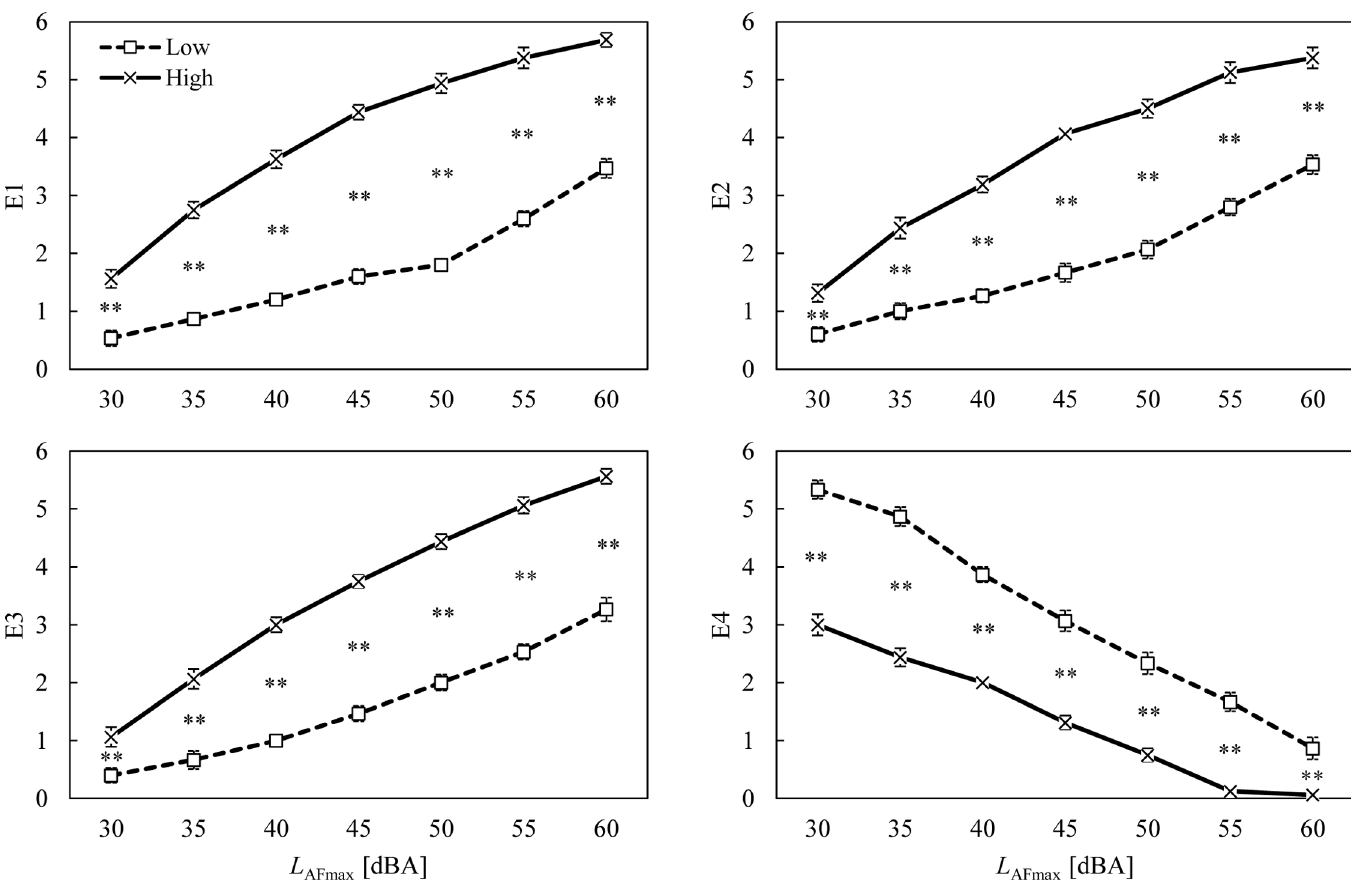
Fig 1. Ratings of perceived emotions for low ( □ ) and high (×) noise-sensitivity groups as a function of noise level. Error bars indicate standard errors. Asterisks indicate significant differences between means according to the Mann-Whitney U test ( (cid:3) p < 0.05 and (cid:3)(cid:3) p < 0.01).